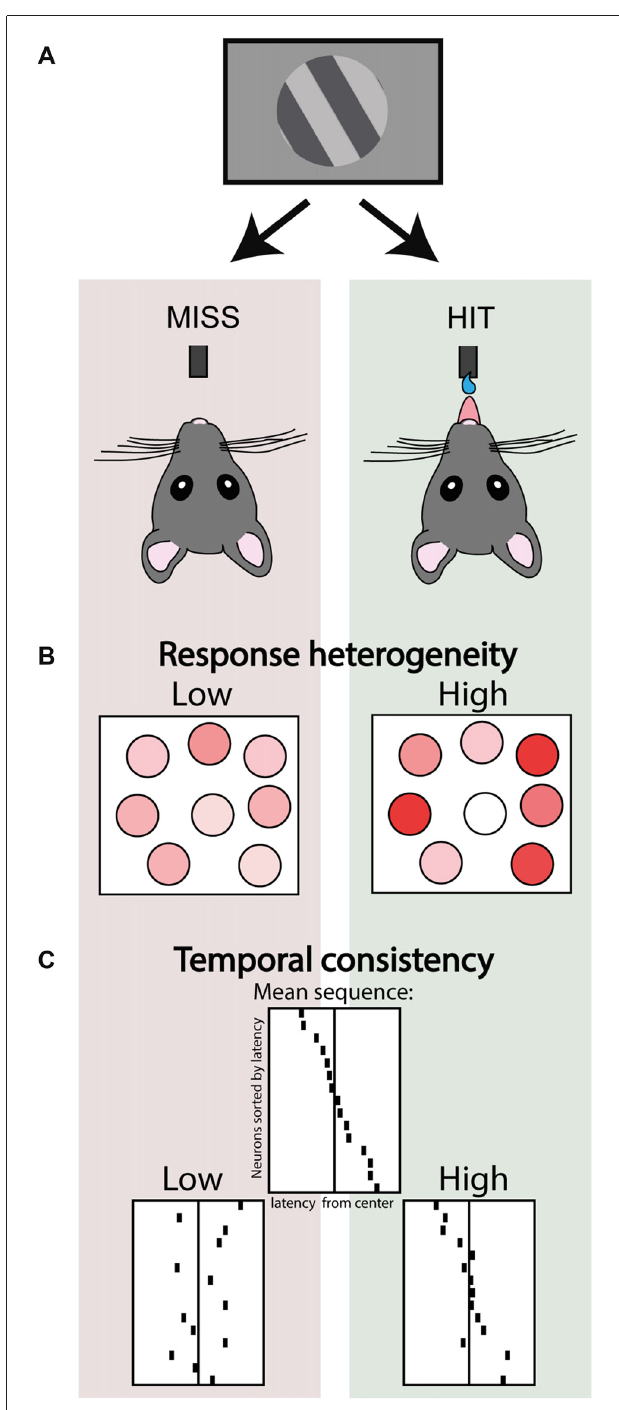
FIGURE 3 | Ensemble activity correlates of stimulus detection. (A) Schematic depicting two trial outcomes in a visual detection task performed by head-fixed mice. In the left scenario a threshold stimulus is not detected (miss trial), whereas in the right the same stimulus is correctly detected (a rewarded hit trial). (B) Simultaneous 2-photon imaging of V1 neuronal populations in these mice revealed that hit trials were associated with higher